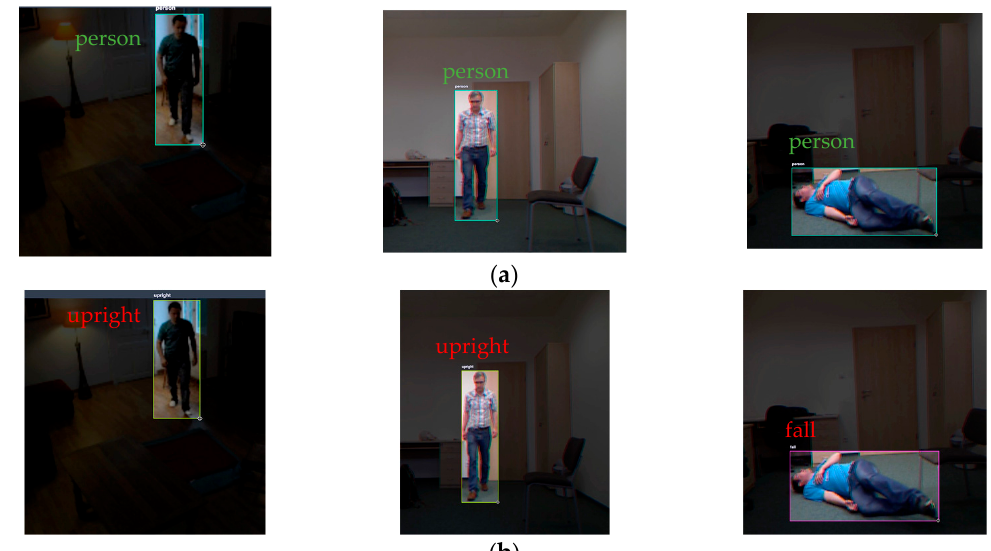
Figure 2. The detection results of YOLOv5 and Manual post-correction. ( a ) YOLOv5 pre-trained model. ( b ) Manual post-correction.